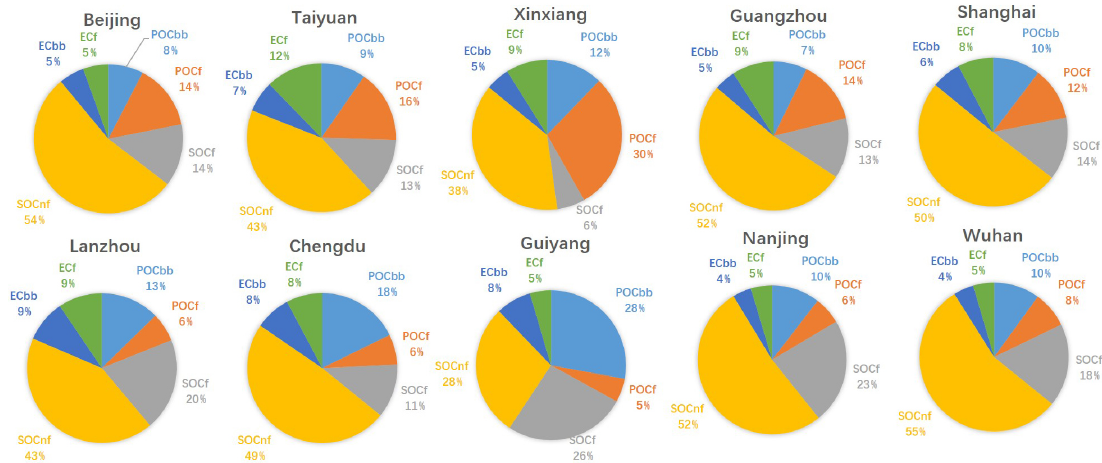
Figure 2. The proportions of different carbon fractions, including elemental carbon derived from fossil fuels (EC f ), EC derived from burning biomass (EC bb ), BB-derived primary organic carbon (POC bb ), POC derived from FF (POC f ), non-FF secondary OC (SOC nf ) and SOC derived from FF (SOC f ) in total carbon (TC) for 10 urban cites during the sampling